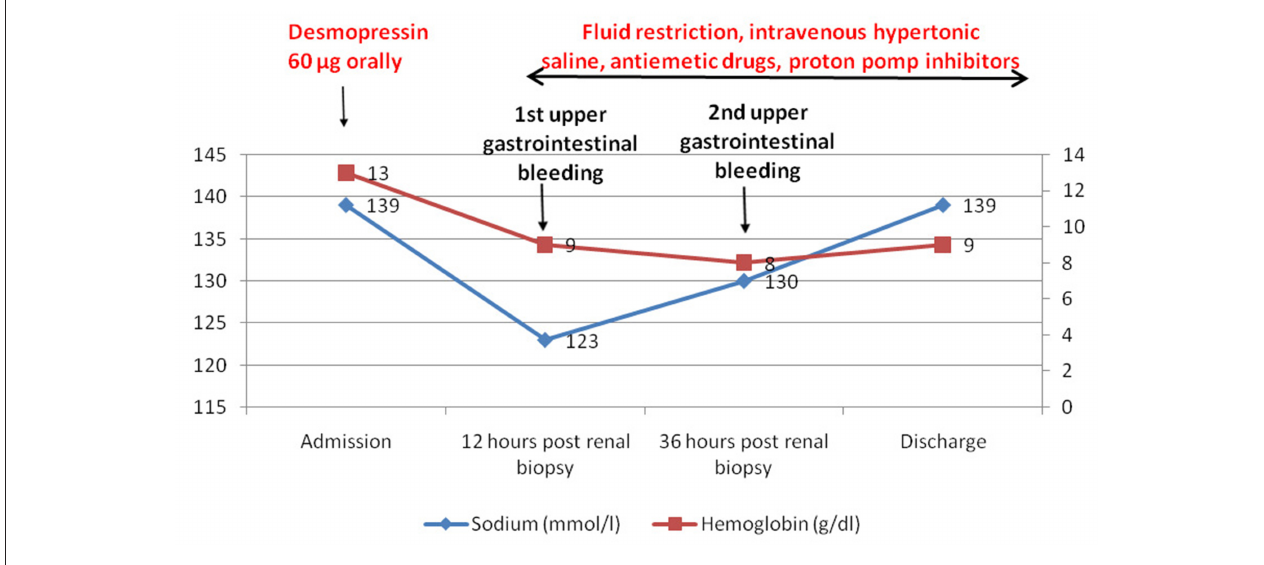
FIGURE 2 | Timeline of the episode of care showing the evolution of serum sodium and hemoglobin